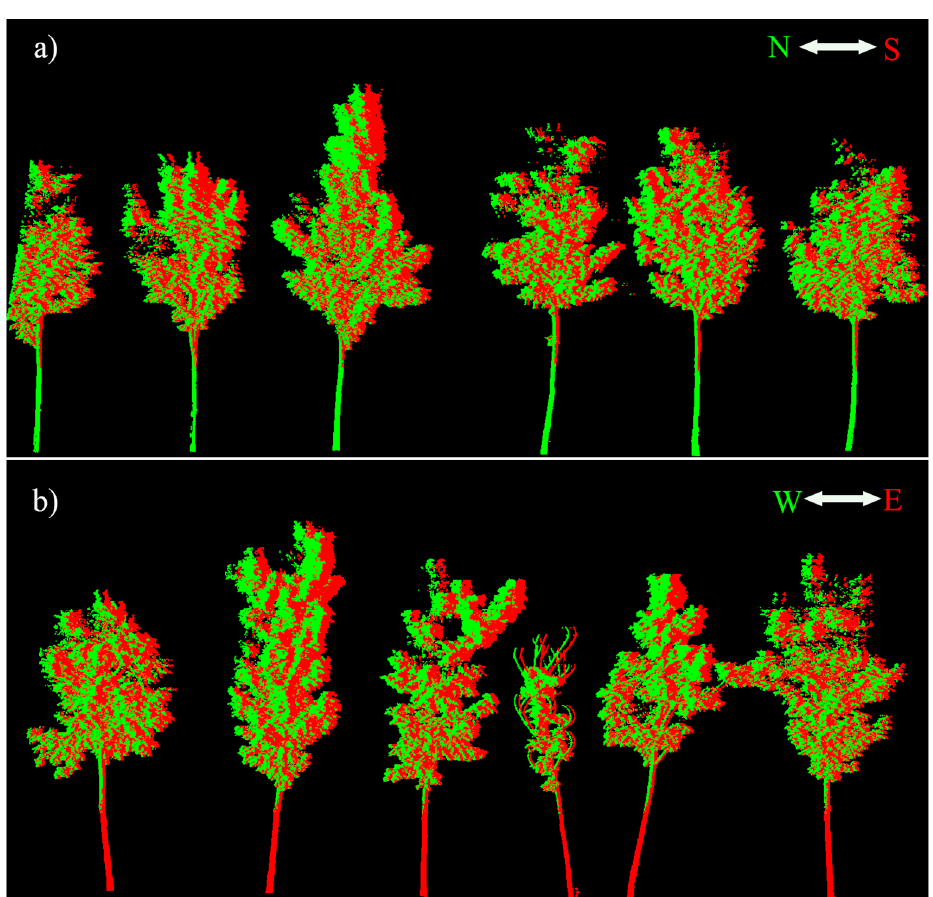
Figure 12. Movement of leaves and branches in canopy point clouds. In the view from the west, red and green represent the northward and southward shifted canopy (inset a ), respectively. In the view from the south, red and green represent the eastward and westward shifted canopy (inset b ), respectively. Table 3. The differences between sunlit leaf fractions calculated based on displaced point clouds and the reference one calculated based on the non-displaced point cloud (differences = displaced—non-